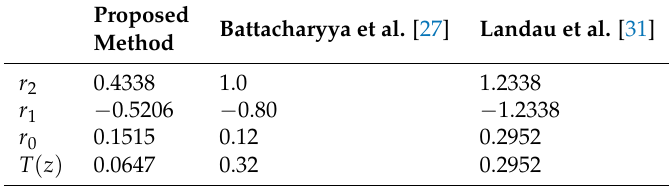
Table 2. Gain values of the digital controller of all methodologies